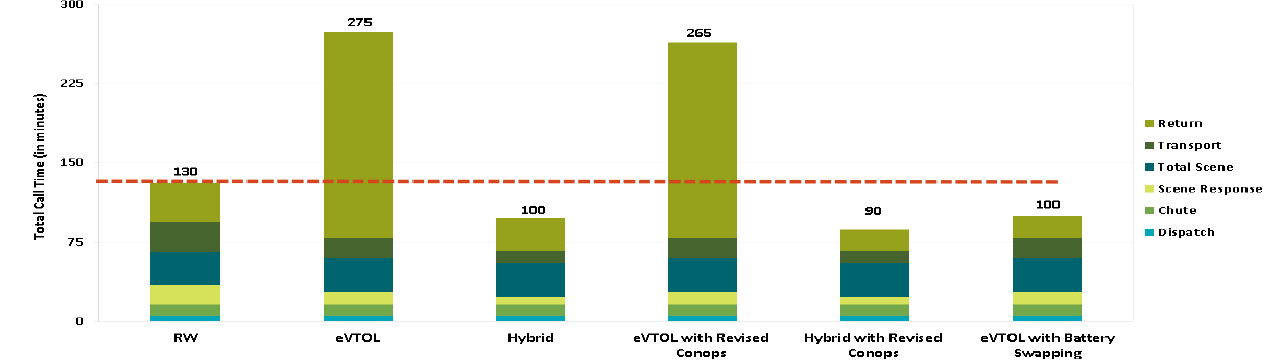
Figure 8. Comparison of total call time for various aircraft and scenarios.